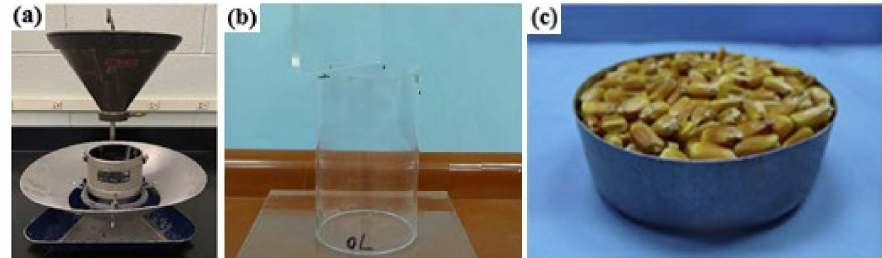
Figure 1. Bulk density